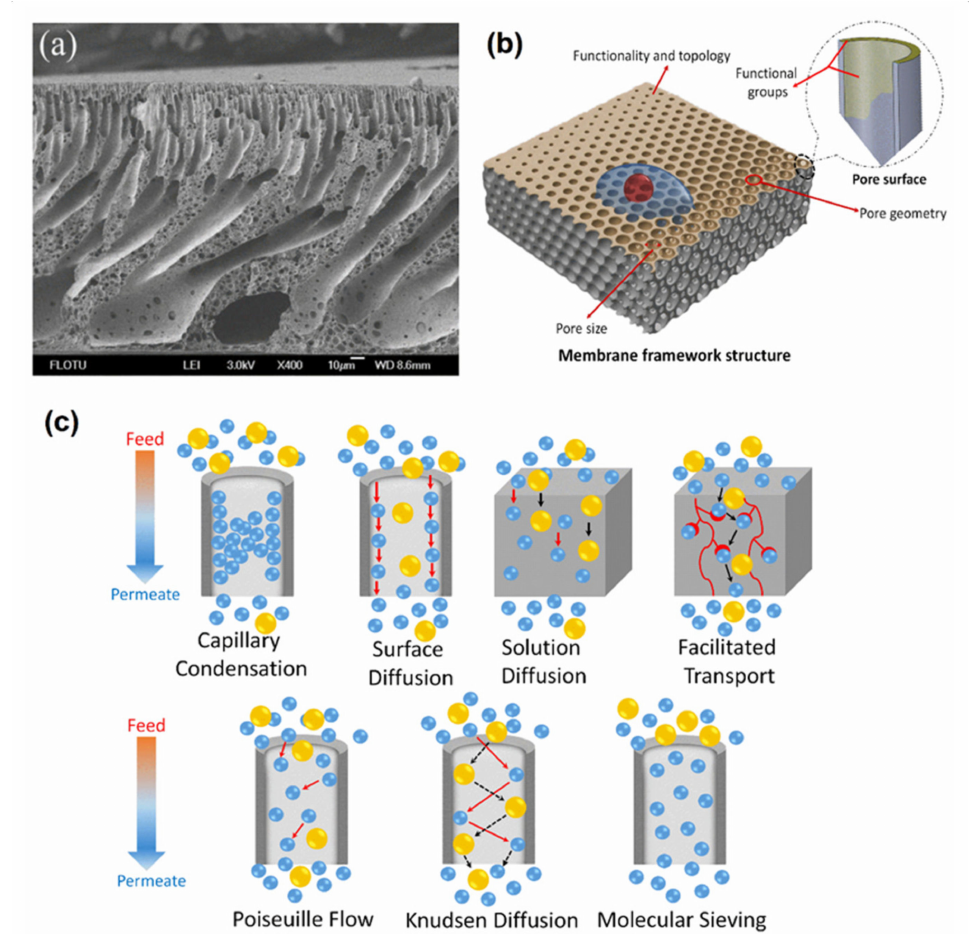
Figure 13. ( a ) SEM image of manufactured integrated asymmetric porous membrane; ( b ) schematic representation of pore size, pore geometry, pore surface, and structure of porous polymers; ( c ) schematic illustration of foremost transport